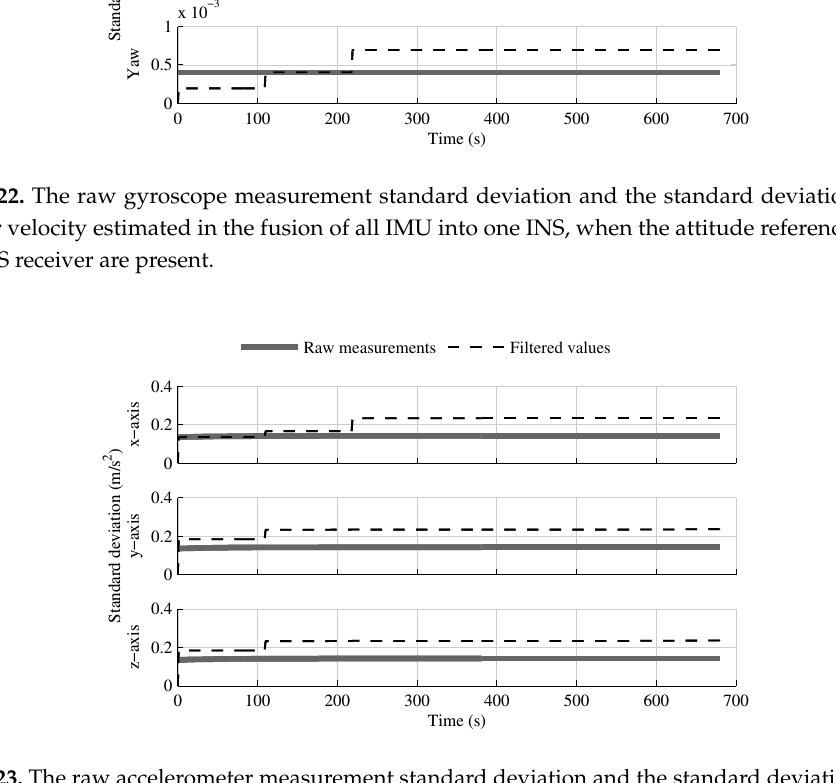
Figure 23. The raw accelerometer measurement standard deviation and the standard deviation of the acceleration estimated in the fusion of all IMU into one INS, when the attitude reference sensor and GPS receiver are